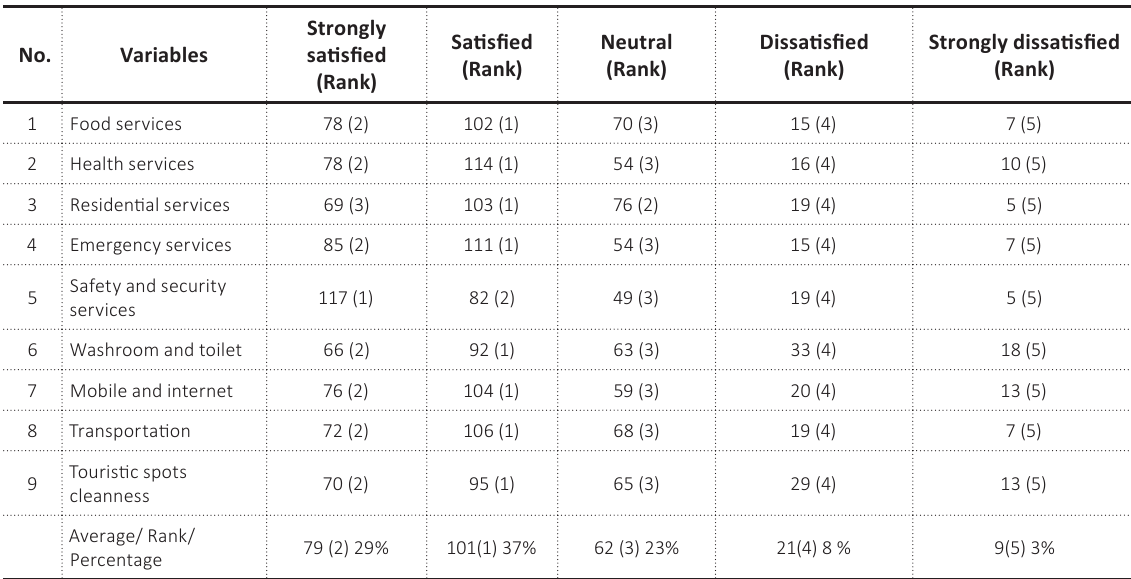
Table A6. Tourists’ responses about essential services and facilities of Saudi Arabian tourism